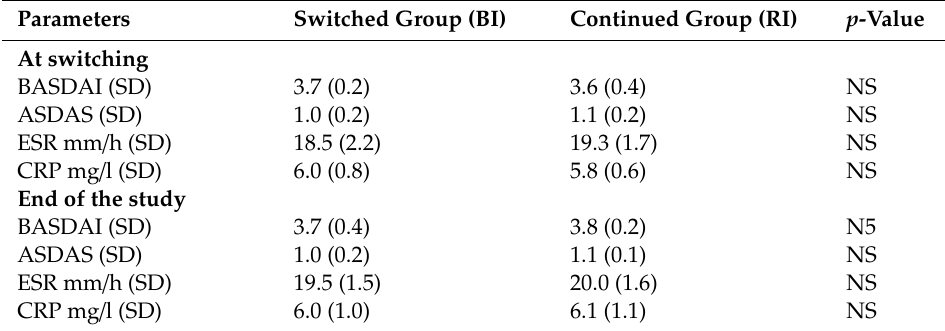
Table 2. Response to treatment in AS patients switched to BI versus those continuing RI.